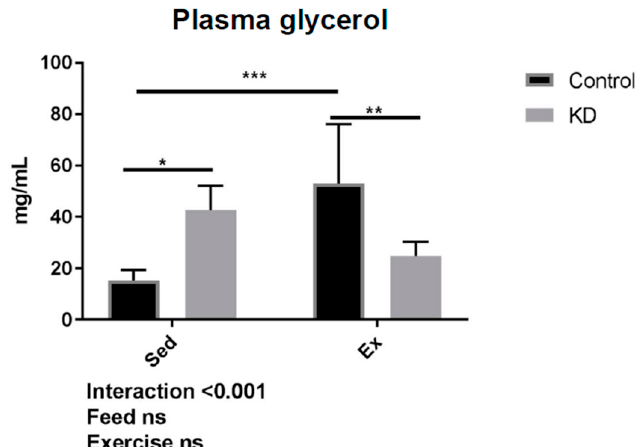
Figure 8. Plasma glycerol concentration after exhaustion. ns: no significance observed. * p < 0.05, ** p < 0.01, *** p < 0.001.